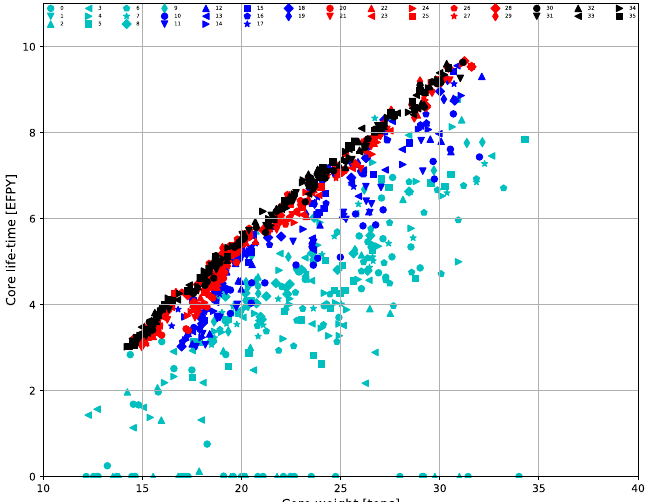
Figure 4. Pareto Frontier obtained from the multi-criteria optimization. Each generation of solution is shown with different shapes and